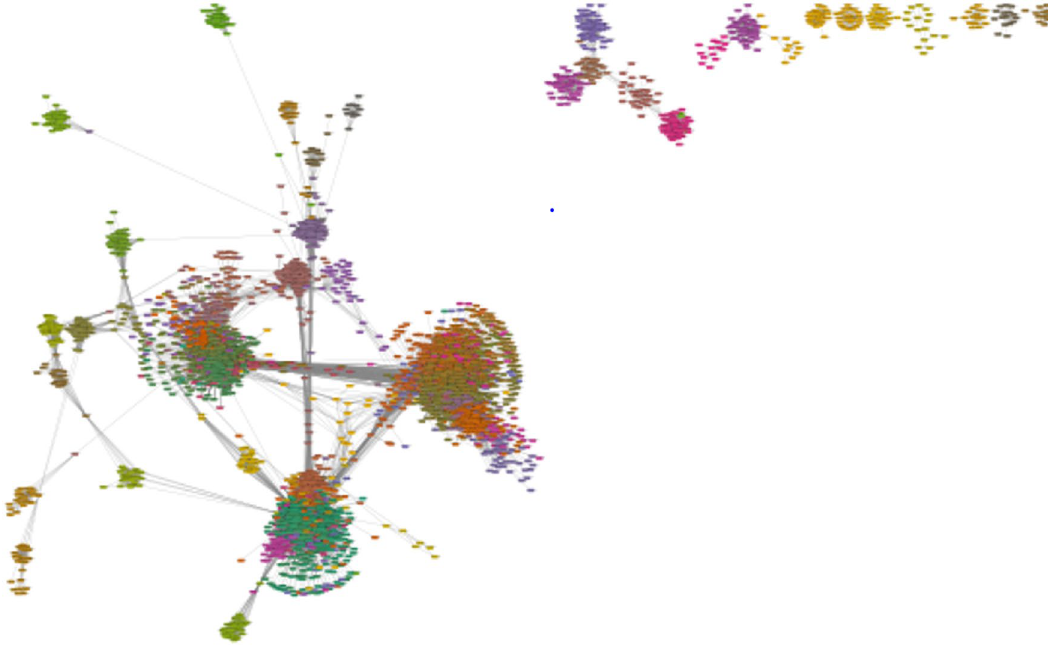
Figure 3. Gene co-expression network of SARS-CoV-2 infected humans. Gene modules are highlighted in different colors. Genes (nodes) are represented as small rectangular boxes and edges are represented by silver lines.